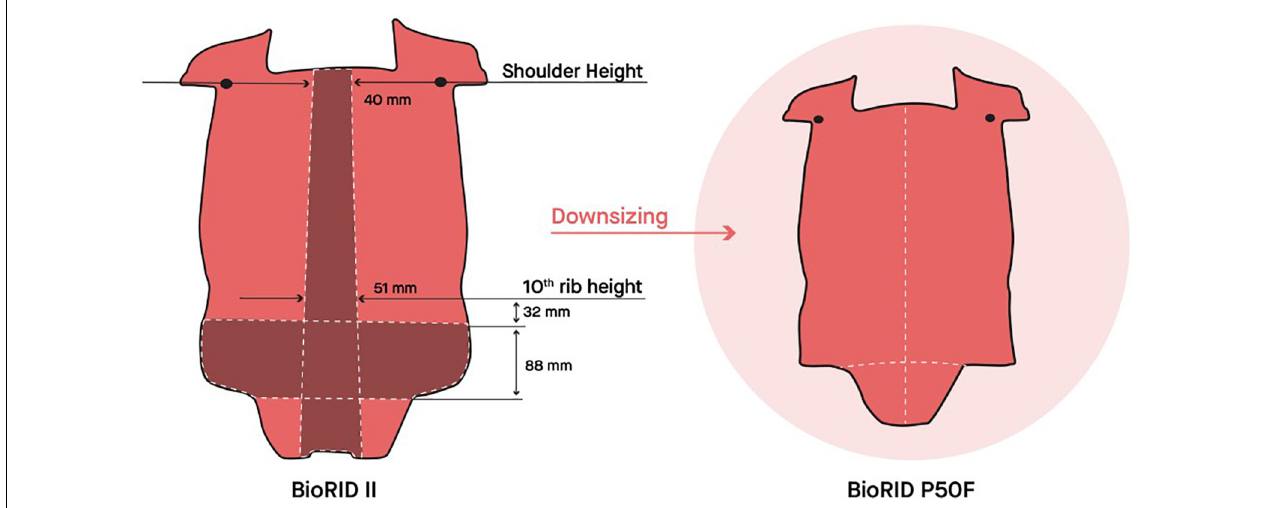
FIGURE 2 | The torso jacket of the BioRID P50F prototype was made by removing the dark segments from the torso jacket of the BioRID II. Illustration courtesy of A. Hedenström.